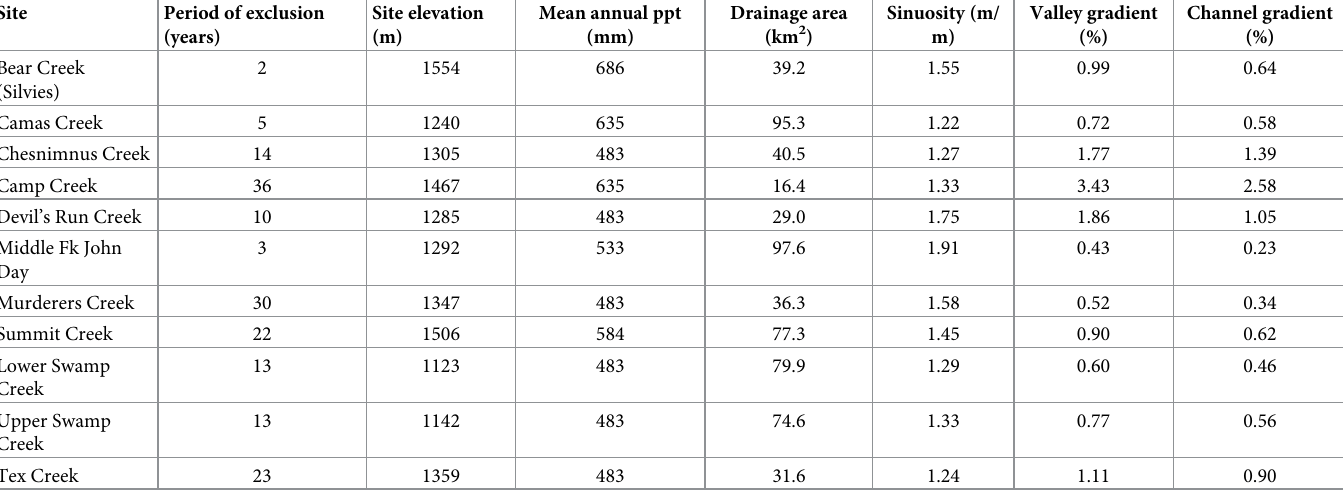
Table 1. Site characteristics of the 11 stream reaches selected for study in northeastern Oregon, USA. Site Period of exclusion